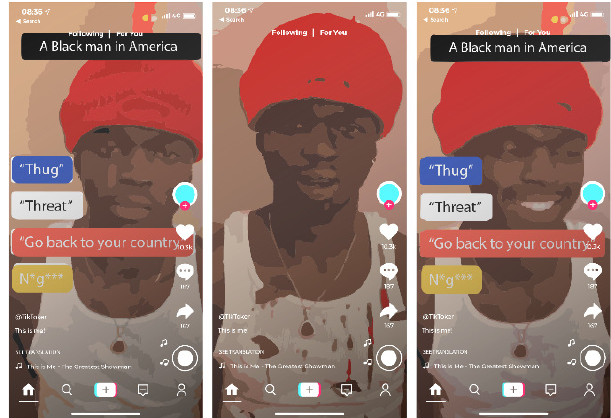
Figure 4. Illustrated TikTok post about racism and